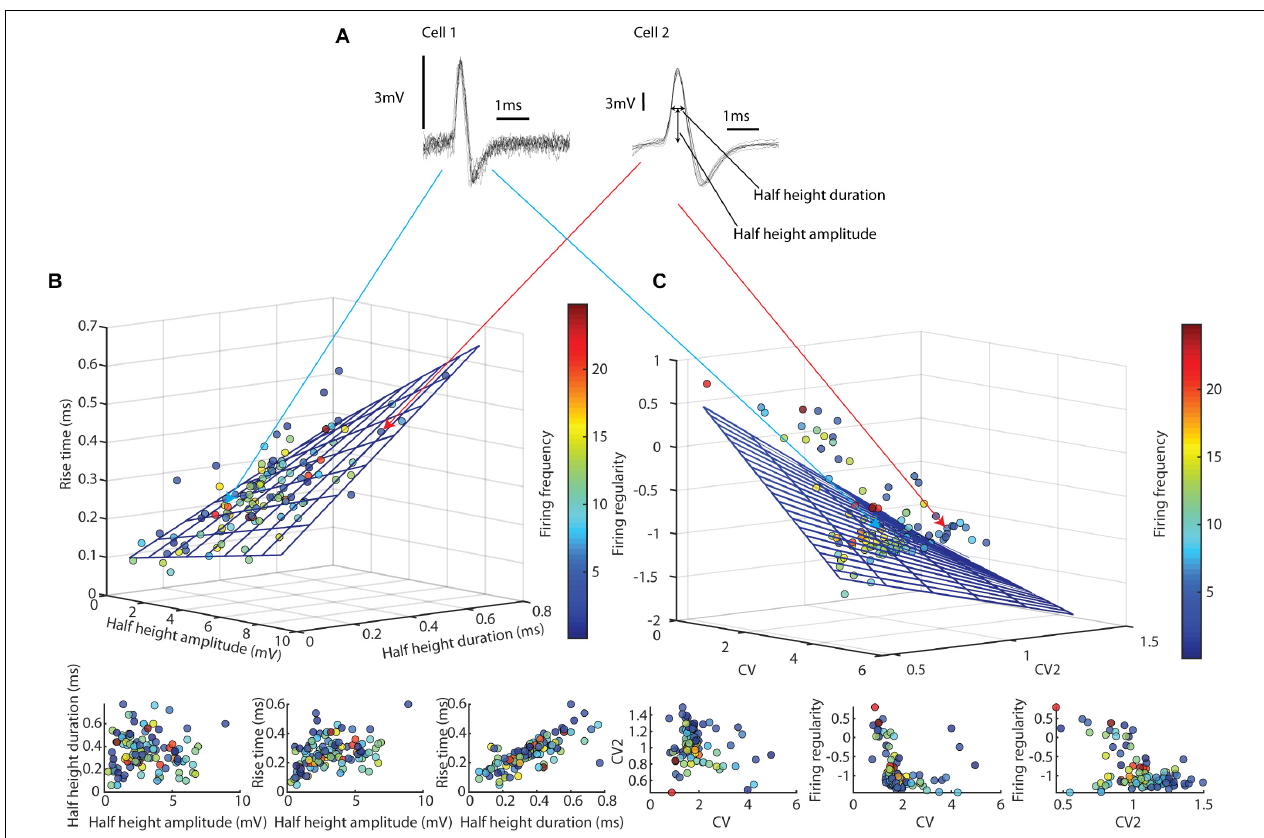
FIGURE 1 | Spike firing metrics suggested that thalamic neurons formed a continuum, thus not offering a basis for subdividing our thalamic neurons into classes. (A) The spike shapes of two different thalamic neurons. Each example consists of 10 superimposed traces. (B) Relationship between spike shape parameters across all thalamic neurons recorded. The 3D plot at the top contains a multilinear regression overlaid on the data points. Below, each pairwise relationship is plotted separately. (C) Relationships between three different measures of spike firing regularity. The 3D plot on top contains a multilinear regression overlaid on the data points. Below, each pairwise relationship is shown